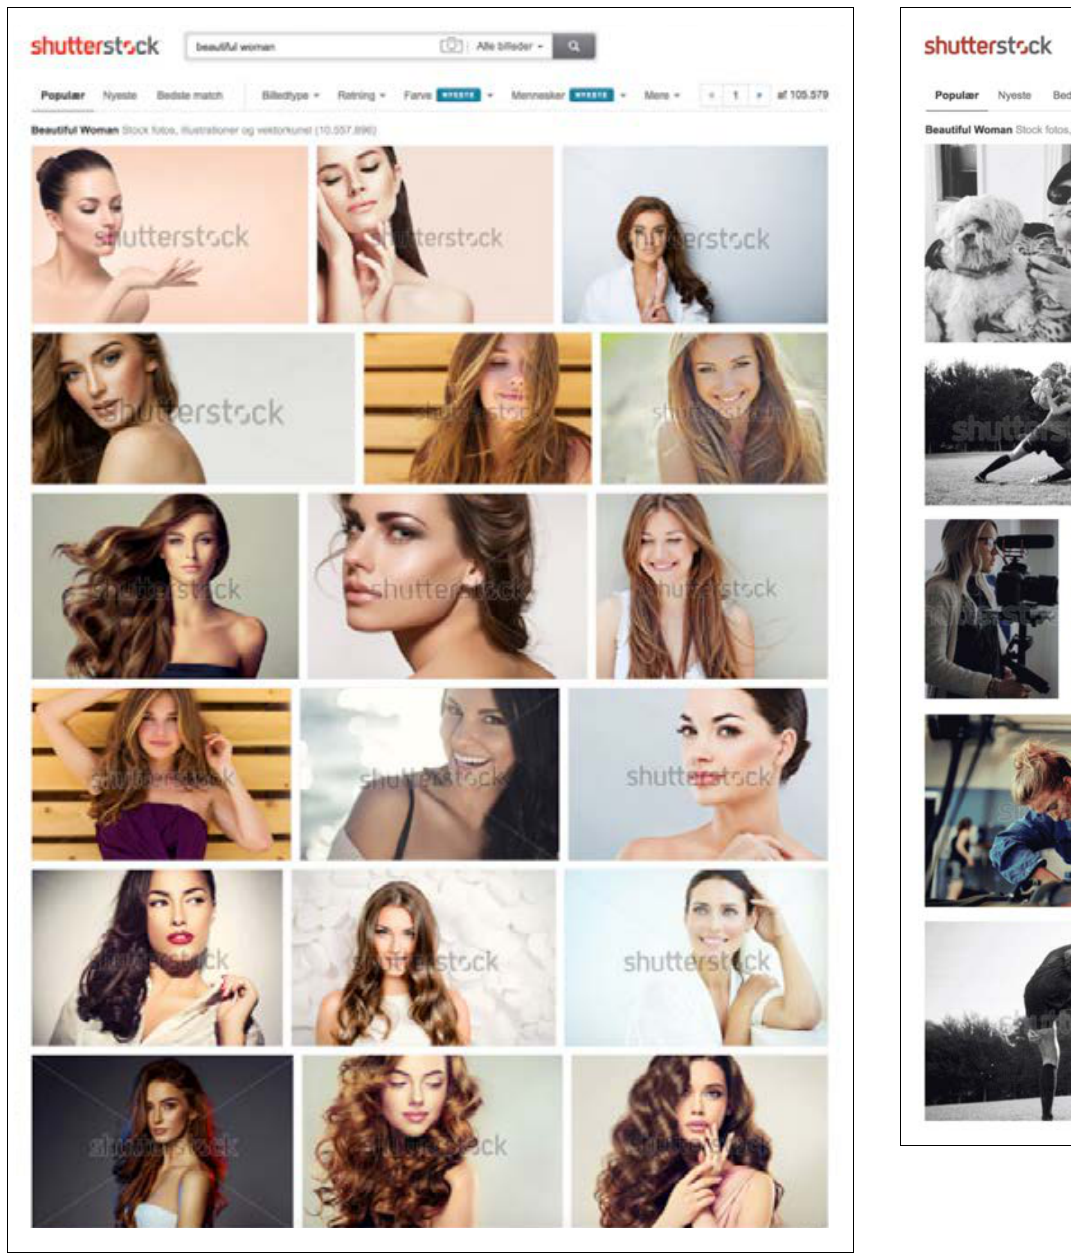
Figure 12 'Before Image_Hack' (left) and Figure 13 'After Image_Hack' (right): The iphiGenia Gender Design Award, founded by the international Gender Design Network (iGDN) in 2017, honours businesses and products that are innovative, gender-sensitive and that strike out in a new direction with regard to gender and design. Mindshare Denmark and their campaign Image_Hack is one of the prize-winners